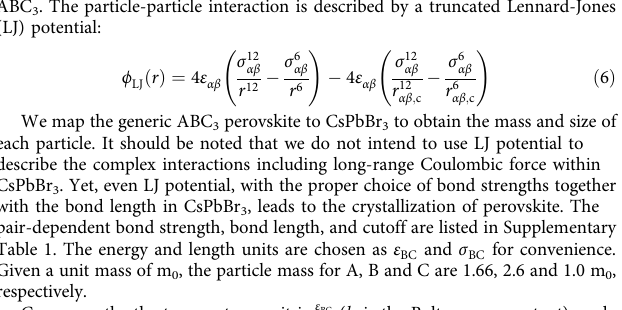
Table 1. The energy and length units are chosen as ε BC and σ BC for convenience. Given a unit mass of m 0 , the particle mass for A, B and C are 1.66, 2.6 and 1.0 m 0